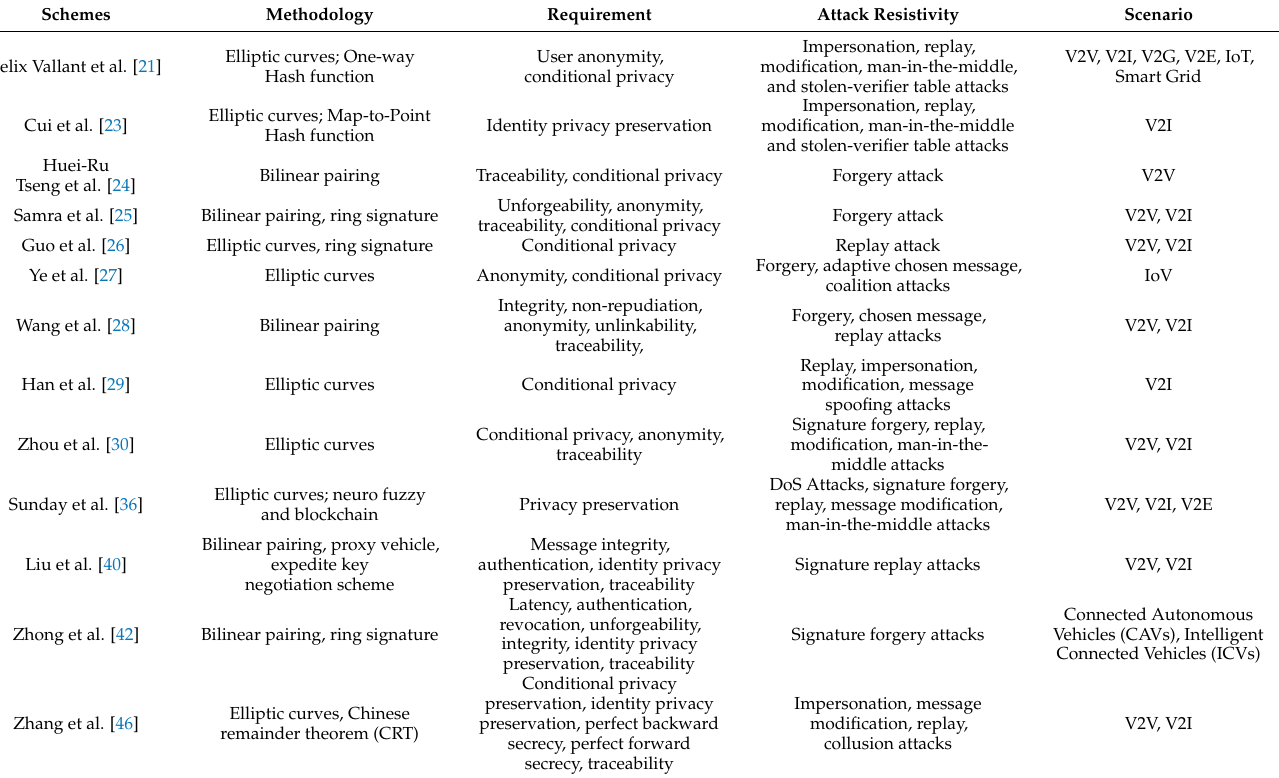
Table 3. Classification of batch-verification-based certificate-less aggregate signature